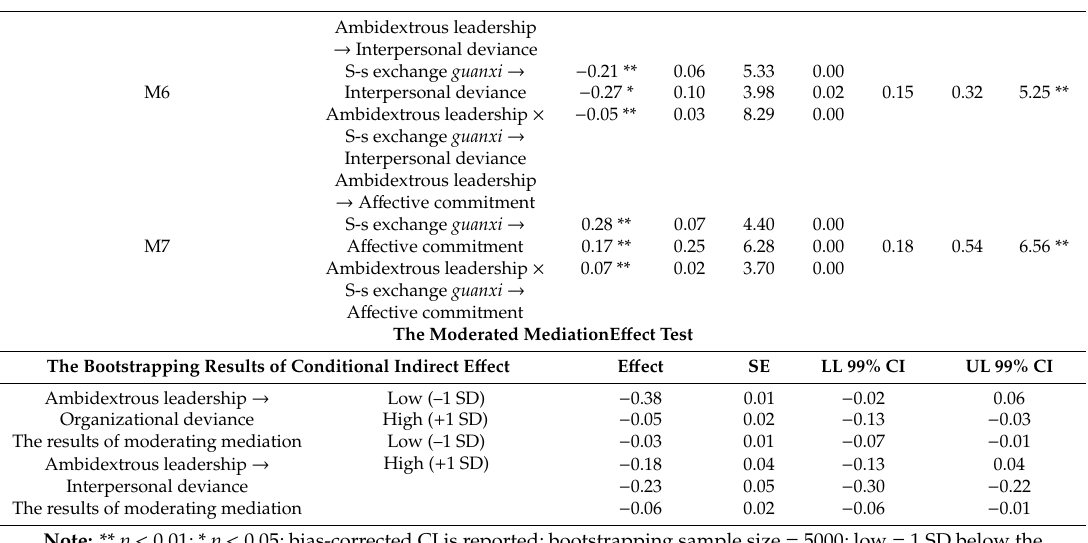
Figure 3. Influence of ambidextrous leadership on interpersonal deviance under different supervisor– subordinate exchange guanxi scenarios. Figure 4. Influence of ambidextrous leadership on affective commitment under different supervisor– subordinate exchange guanxi scenarios. Finally, we applied model 8 of the SPSS PROCESS macro to analyze the indirect effect of ambidextrous leadership on organizational deviance and interpersonal deviance through affective commitment under different degrees of supervisor–subordinate exchange guanxi [69]. At the bottom of Table 3, the index of moderated mediation indicates that any two conditional indirect effects defined by different supervisor–subordinate exchange guanxi scenarios are different statistically. For organizational deviance (index = − 0.03, SE = 0.01, 95%CI = [ − 0.07, − 0.01]), the mediating role of affective commitment between ambidextrous leadership and organizational deviance is not significant for low (effect = − 0.38, SE = 0.01, 95%CI = [ − 0.02, 0.06], contain zero) and is significant for